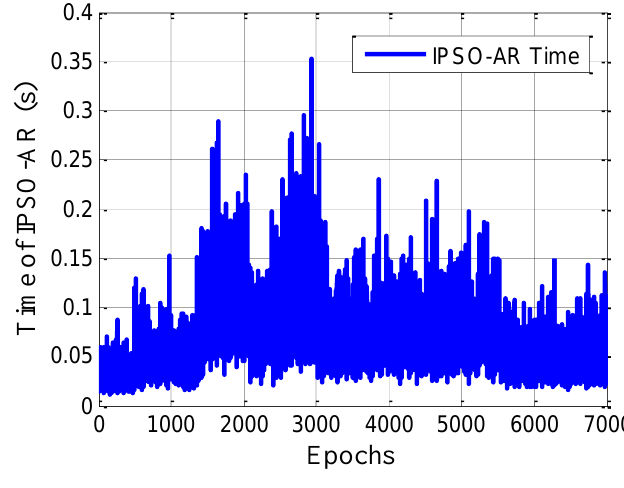
Figure 12. Search time of IPSO–AR.